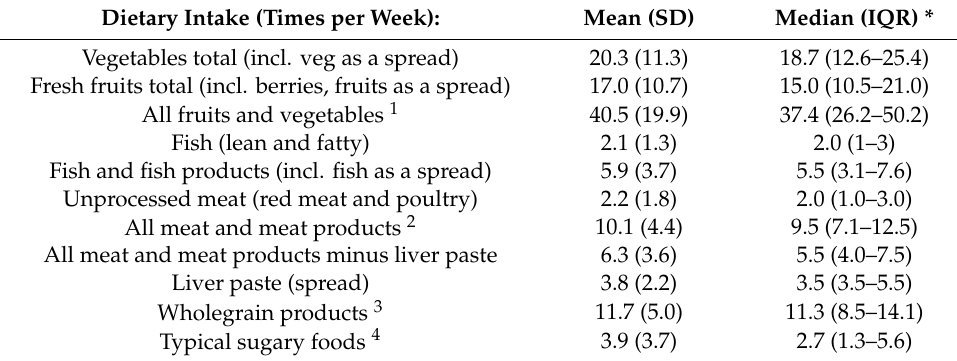
Table 3. Children’s dietary intake at baseline ( n =